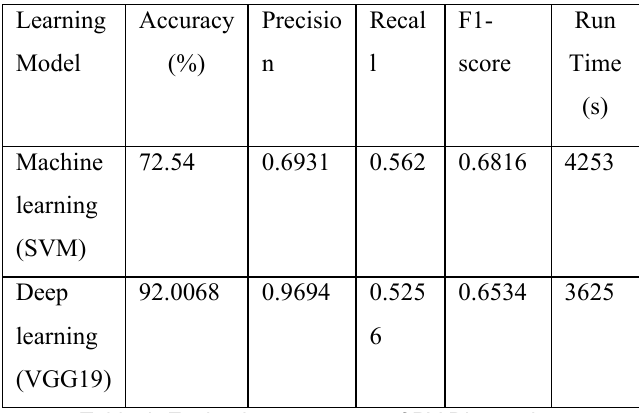
Table 1. Evaluation parameter of PV Diagnosis